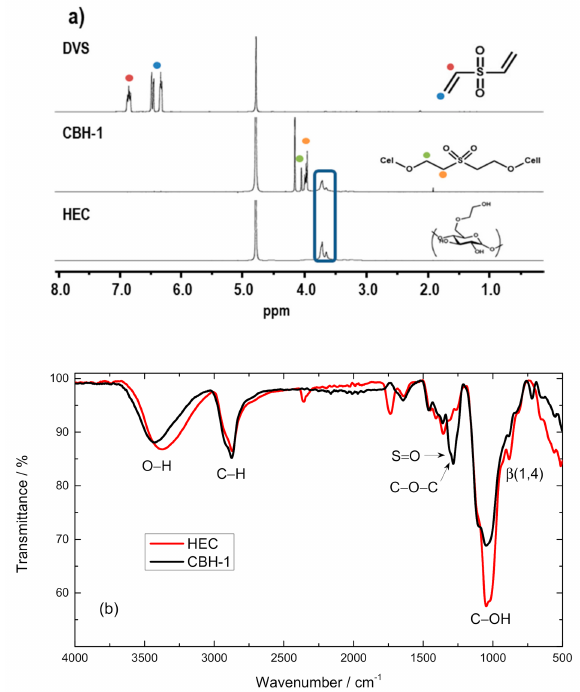
Figure 3. Characterization of the crosslinking reaction: ( a ) H 1 NMR spectra of divinyl sulfone (DVS) (top); CBH-1 (middle) and HEC (bottom); ( b ) spectra of HEC (red) and CBH-1